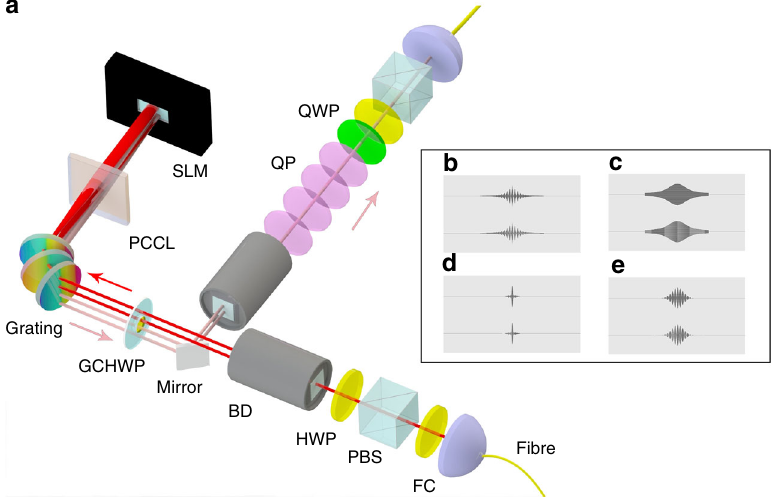
Fig. 1 The experimental setup. a Key to the components: FC — fi ber connector, PBS — polarizing beam splitter, HWP — half-wave plate, BD — beam displacer, GCHWP — glass cemented half-wave plate, PCCL — plano convex cylindrical lense, SLM — spatial light modulator, QP — quartz plate, and QWP — quarter- wave plate. The photon is guided from the source to the device via the lower FC. Then the photon goes through the gratings (the dark red lines) to SLM where the state is manipulated and the photon is re fl ected back (light red lines). A mirror guides the returning photon through the quartz plate combination. Finally, a combination of QWP, HWP, and PBS is used to run tomographic measurement at the end of the device. b – e The holograms used in the experiment so that (b – e) correspond to Fig. 3(a –